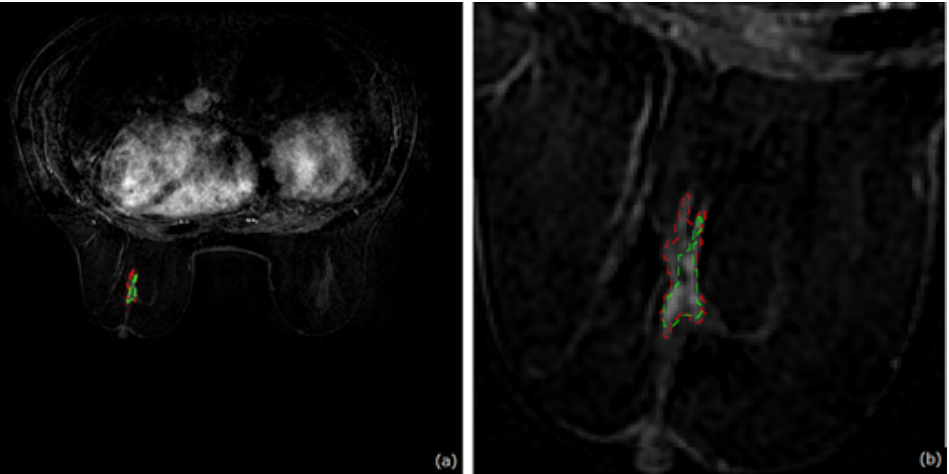
Figure 15. Case with an irregular lesion: ( a ) entire axial DCE-MRI slice; ( b ) crop of the slice shown in ( a ). Comparison between manual ground-truth (green) and automated segmentation